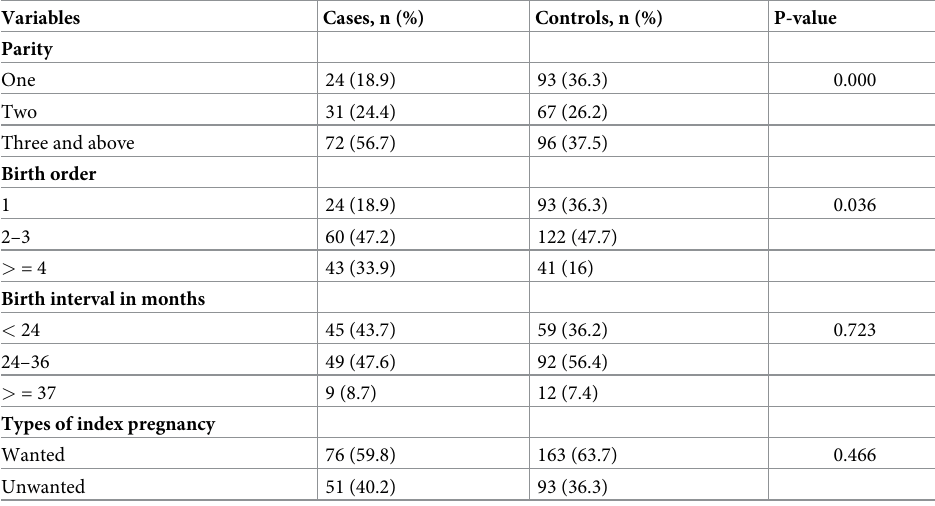
Table 2. Obstetrics characteristics of mothers in Dabat district, Northwest, Ethiopia, 2021.